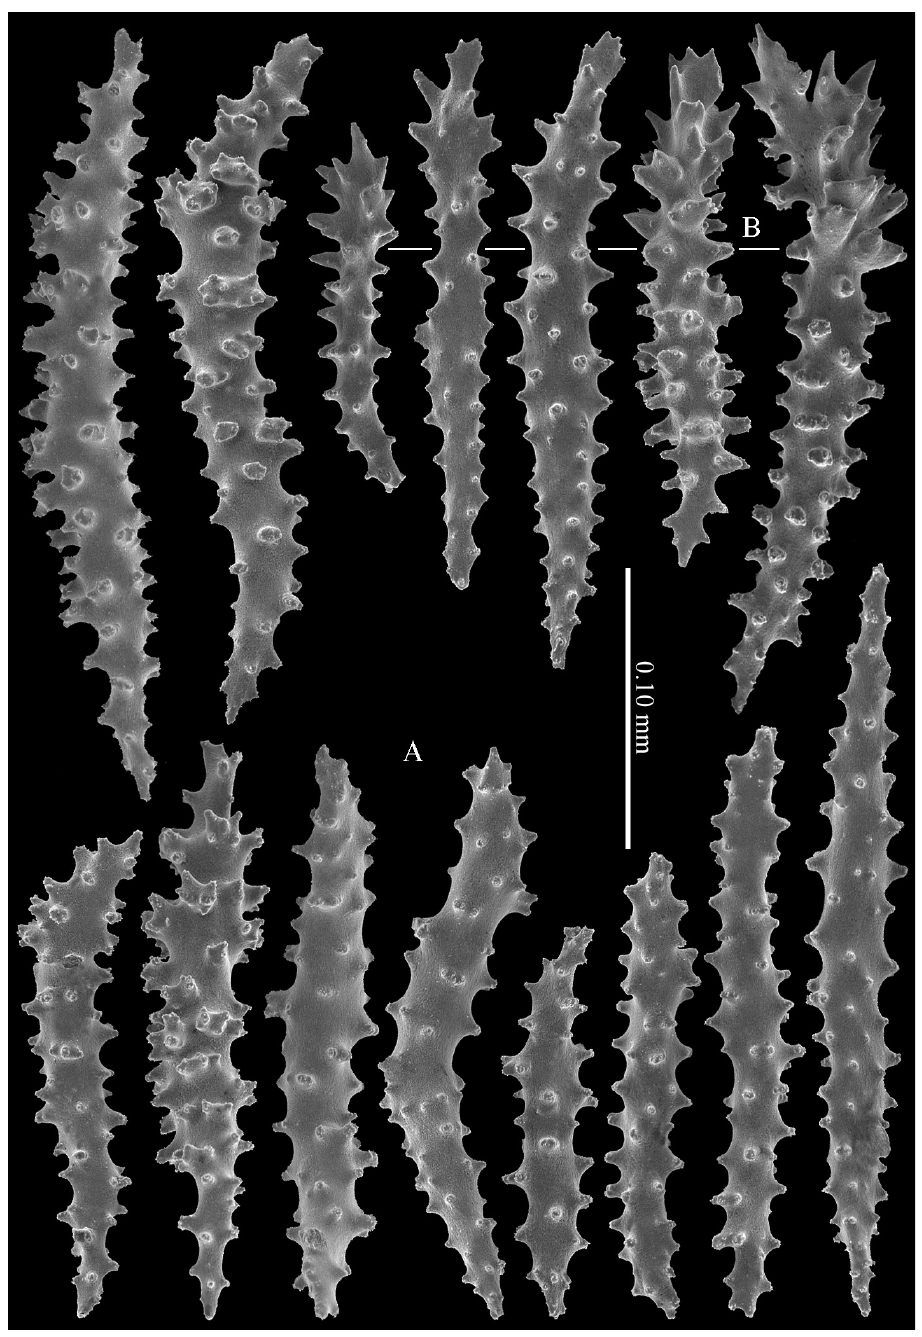
Figure 4. Coenenchymal sclerites of Melithaea davidi sp. n., holotype, RMNH Coel. 42122; A spindles B